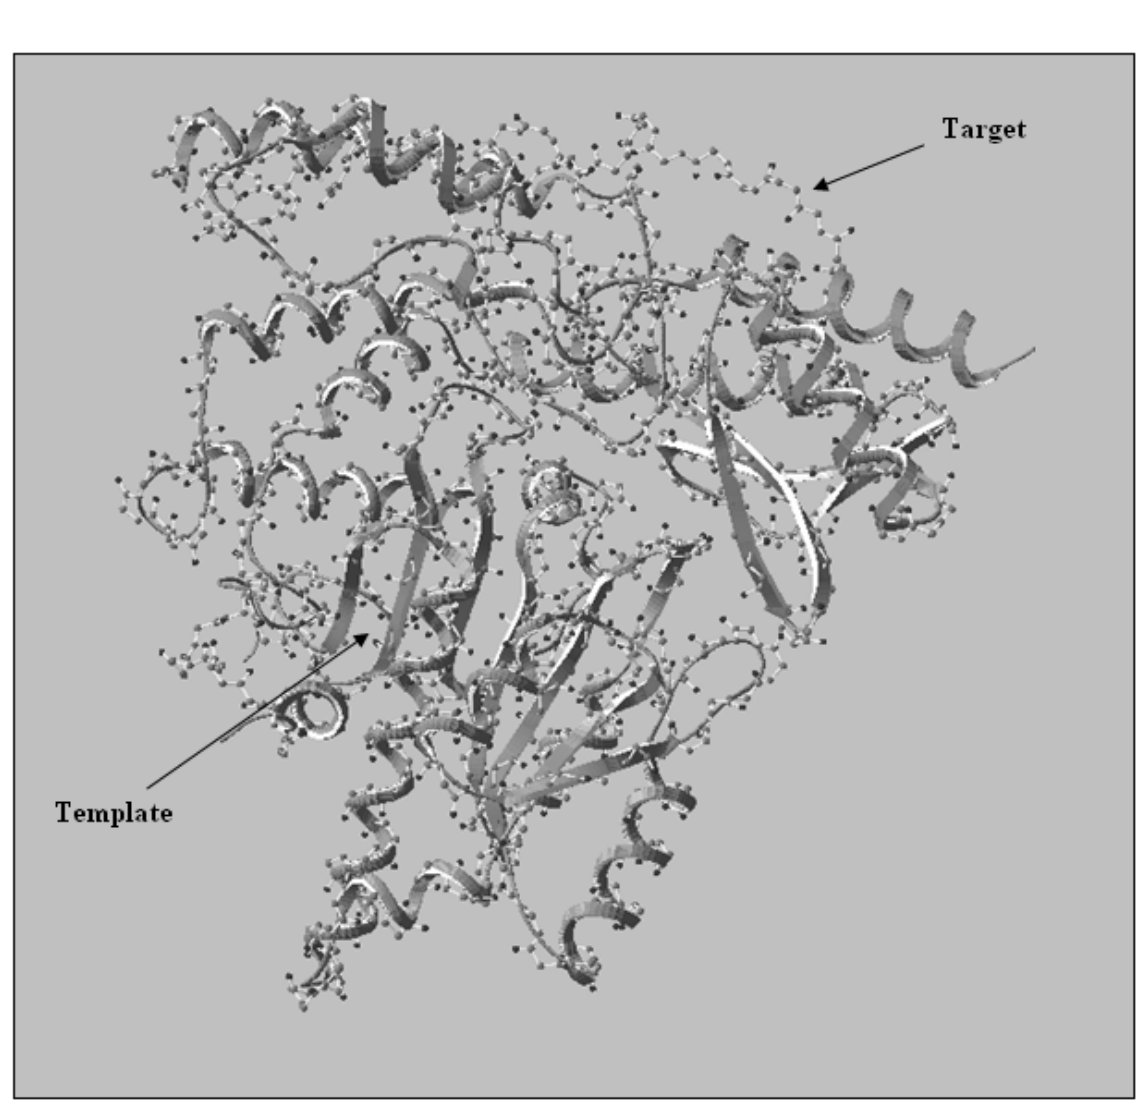
Figure 5: The target sequence is "wrapped" around the template structure. The structure of the target is con- structed by satisfying all the restraints, taken from the template structures, as well as possible. The structure of the target sequence is visualized as a "ball-and-stick" representation. The template structure is visualized as a backbone